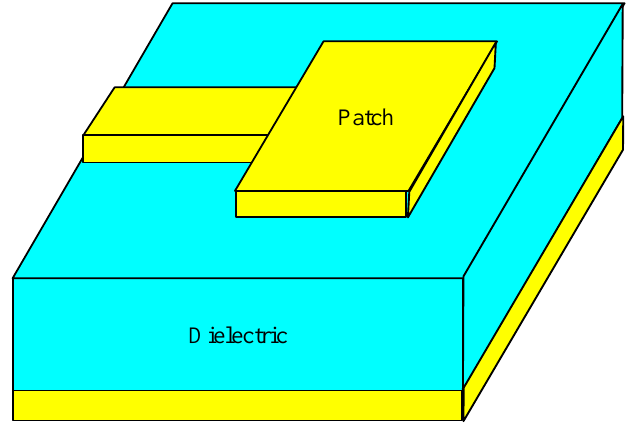
Figure 2. Patch Antennas